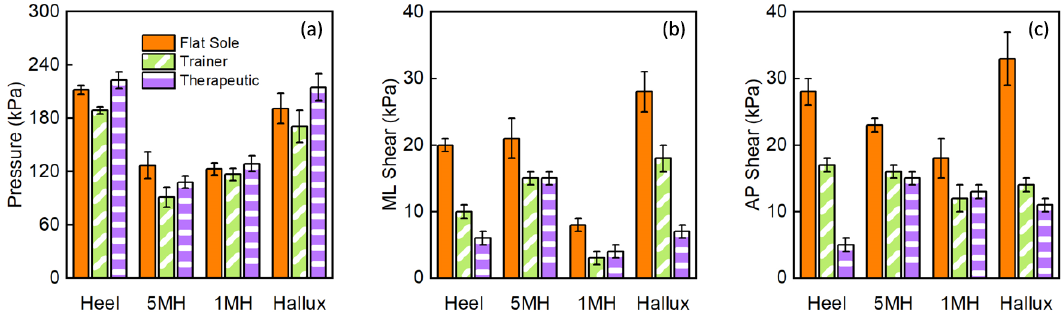
Figure 9. ( a ) Mean peak pressure and ( b ) medial–lateral (ML) and ( c ) anterior–posterior (AP) shear stress obtained over gait cycles with three types of footwear.